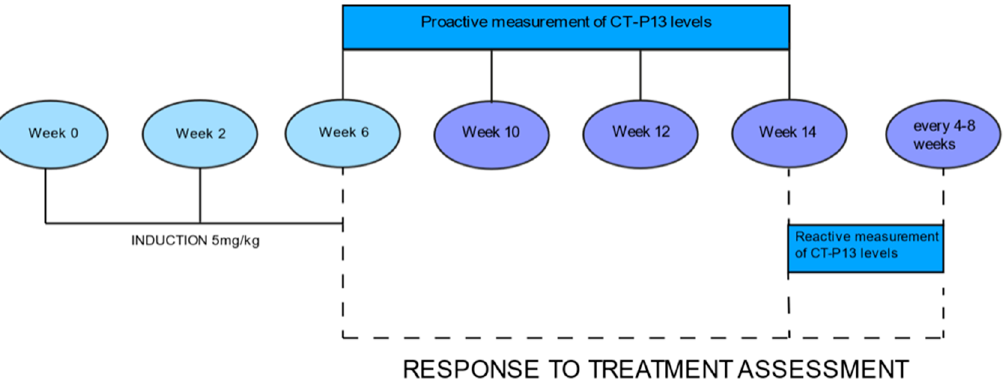
Figure 1. 3 Response to treatment.